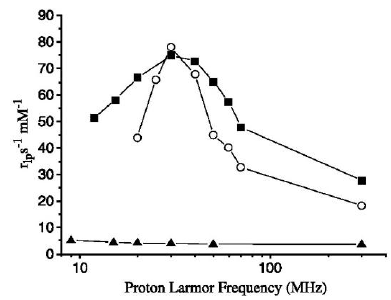
Figure 4. 1/T 1 1 H-nuclear magnetic resonance dispersion (NMRD) profile (9 – 300 MHz (pH 7) and 25